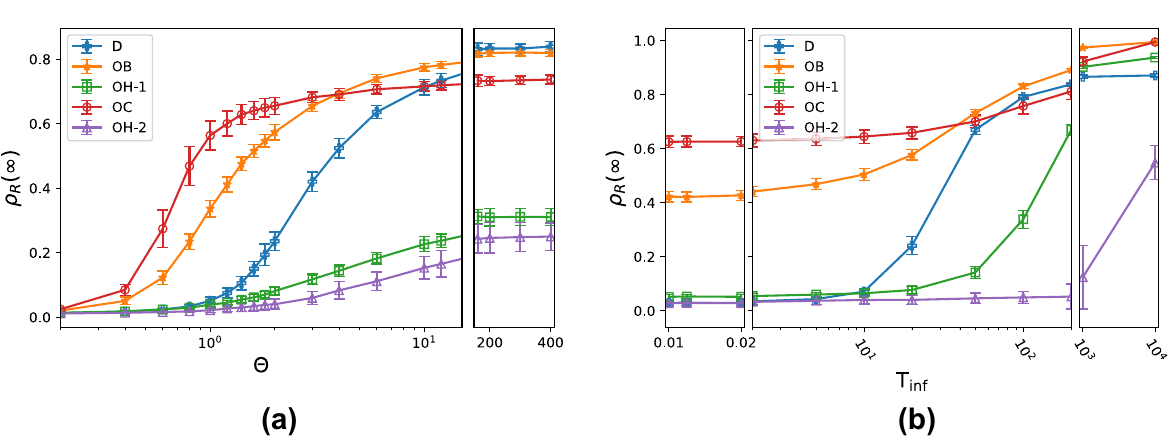
Figure 3. Effectiveness of the epidemic outbreak as a function of the contagion parameters for the five collective states identified in Fig. 1: Disordered (D), ordered with bands (OB), ordered with clusters (OC), and two ordered homogeneous states (OH-1 and OH-2). Each panel presents the fraction of agents that were infected and later recovered during the epidemic outbreak ρ R ( ∞ ) as a function of either the infection-lifetime transmissibility � = β b /γ with fixed T inf = 20 ( a ) or of the mean agent infection duration T inf = 1 /γ with fixed (cid:31) = 2 ( b ). Each point shows the mean ρ R ( ∞ ) value for 50 simulations and the error bars, its standard